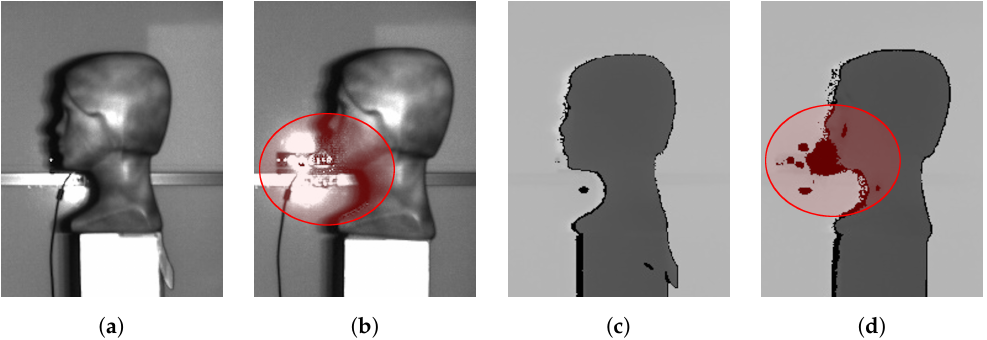
Figure 3. Images from Microsoft Kinect v2 sensor: ( a ) Infrared (IR) frame without interference. ( b ) IR frame with interference. ( c ) Depth image of ( a ) IR image. ( d ) Depth image of ( b ) IR image. Interference is marked with red oval.